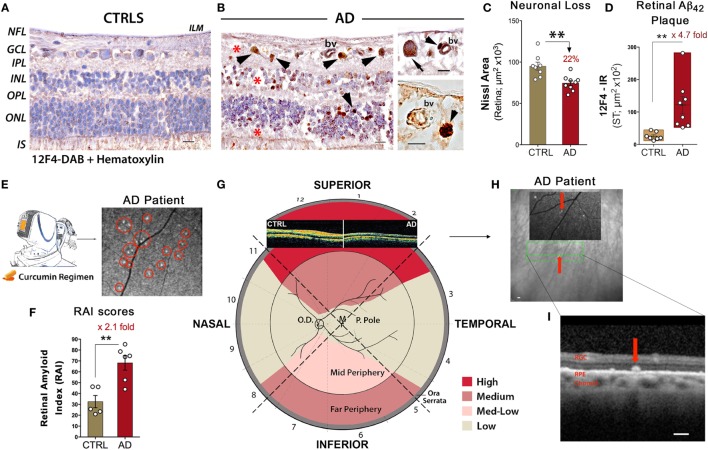
Noninvasive retinal imaging in Alzheimer’s patients: detecting Aβ deposits and nerve degeneration via scanning laser ophthalmoscopy and optical coherence tomography. (A,B) Retinal cross sections from superior quadrants of Alzheimer’s disease (AD) patients (n = 12) and matched healthy controls (CTRL; n = 8) stained with anti-Aβ42 mAbs (12F4) and peroxidase-based labeling (brown). Hematoxylin counterstain for nuclei (violet). Retinas of AD patients contained a multitude of Aβ deposits (arrowheads), especially in the ganglion cell layer (GCL). Marked loss of retinal cells is apparent in the GCL, inner nuclear layer (INL), and outer nuclear layer (ONL); areas of nuclei loss are indicated by red asterisks. The inner limiting membrane (ILM) and retinal nerve fiber layer (RNFL) are intact in CTRL in contrast to AD. Scale bars = 20 μm. Higher magnification images [(B), right panel] show Aβ deposits near and inside blood vessel walls (bv; arrowheads) and inside ganglion cell soma (arrow). Scale bars = 10 μm. (C) Quantitative Nissl neuronal area in AD patients (n = 9) and age- and gender-matched CTRL (n = 8) revealing a significant reduction in AD patients. (D) Quantitative analysis of 12F4-immunoreactive (IR) area of Aβ42-containing plaques in the superior quadrant of retinal flatmounts in a subset of definite AD patients (n = 8) and matched controls (n = 7) showing a significant increase of Aβ42 plaques in AD patients. (E) Schematic of a noninvasive retinal amyloid imaging method using curcumin (Longvida®) to label retinal Aβ in live human patients. Subjects’ retinas were imaged with a modified scanning-laser ophthalmoscope prior to and following curcumin intake. White spots marked by red circles are curcumin-positive amyloid plaques detected in the retina of a living AD patient. (F) Scatter bar plot displays retinal amyloid index (RAI) scores, a fully automated calculation of increased curcumin fluorescence representing amyloid deposits in the retina. AD patients (n = 6) showed a significant increase in RAI score in comparison to age-matched CTRL (n = 5). (G) Qualitative mapping of the “geometric hotspot” regions of Aβ deposits in retinal quadrants of AD patients. Schematic of OCT images from an AD patient vs. control are shown [adopted from: Coppola et al. (21)]. (H) OCT image of a selected curcumin-positive plaque (red arrow) in an AD patient with no maculopathy. Certain retinal amyloid plaque visualized by curcumin fluorescence fundography in insert. Green lines delineate region of OCT segmentation. (I) Retinal cross section by OCT reveals amyloid plaque in outer retinal layers; curcumin-positive deposit located above retinal pigment epithelium (RPE), along with intact RPE and Bruch’s membrane. Scale bars = 200 μm. Group means and SEMs are shown. *p < 0.05 and **p < 0.01, unpaired two-tailed Student’s t-test. Images and data of (A–I) panels, except for part of (E), are modified reprinted from Koronyo et al. (26).